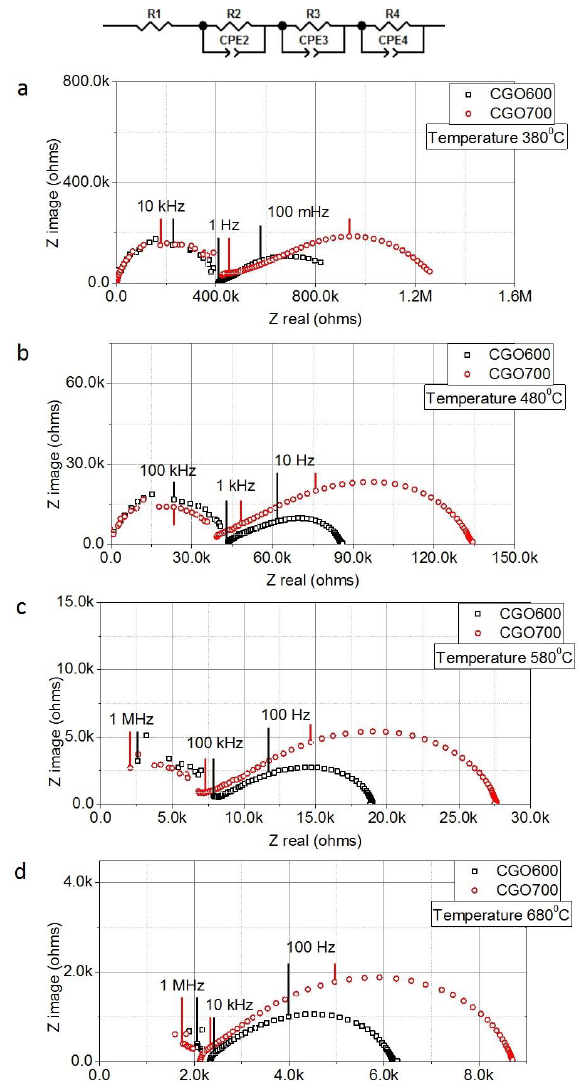
Figure 5. Equivalent circuit and Nyquist plots for CGO600 and CGO700 in the range of temperature investigated increasing respectively from ( a ) – ( d ).